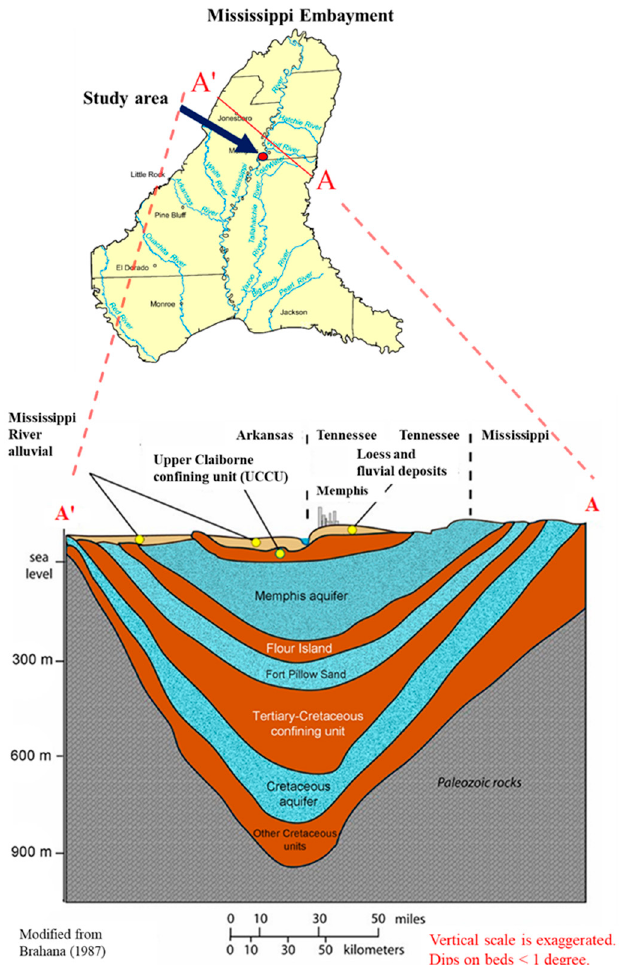
Figure 1. A–A’ hydrogeological section of the Memphis groundwater system, through the Mississippi Embayment. It represents four aquifers and four confining units. Note that the vertical axis is dramatically exaggerated for visualization purposes. The study area is shown as a red circle in the Mississippi Embayment map.